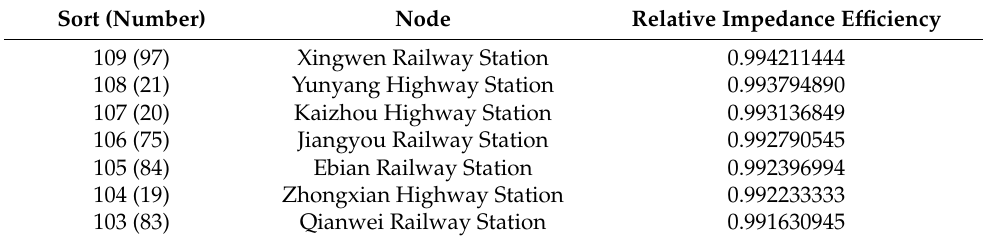
Table 2. Nodes that have a small impact on network performance. Sort (Number) Node Relative Impedance